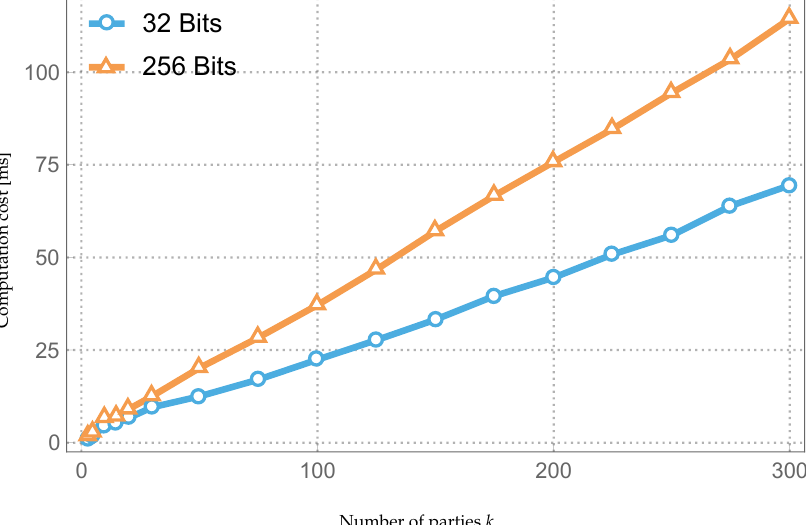
Figure 6. Cost of shares decryption and signatures